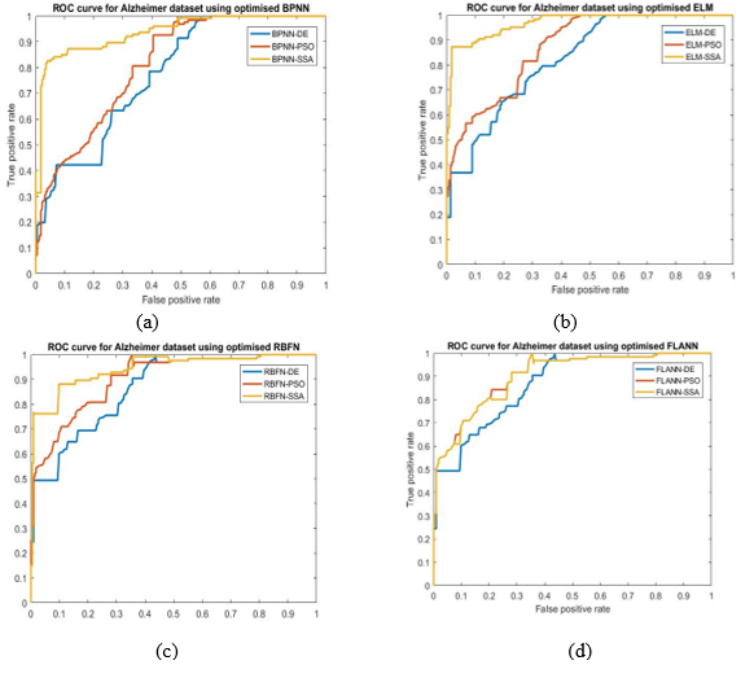
Figure 11. Comparison of ROC plots for Alzheimer’s dataset using classifier ( a ) BPNN, ( b ) ELM, ( c ) RBFN, or ( d )